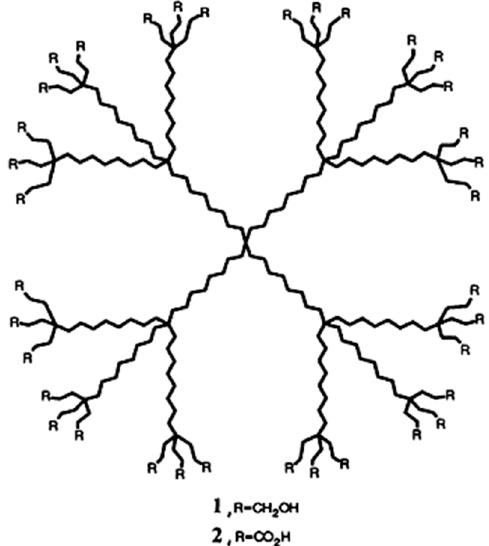
Figure 12. A generation 2, cascade polymer referred to as [8 2 · 3] micellanoic acid / alcohol exhibited unimolecular micelle behavior. Reprinted with permission from [54]. Copyright 1991 John Wiley & Sons.